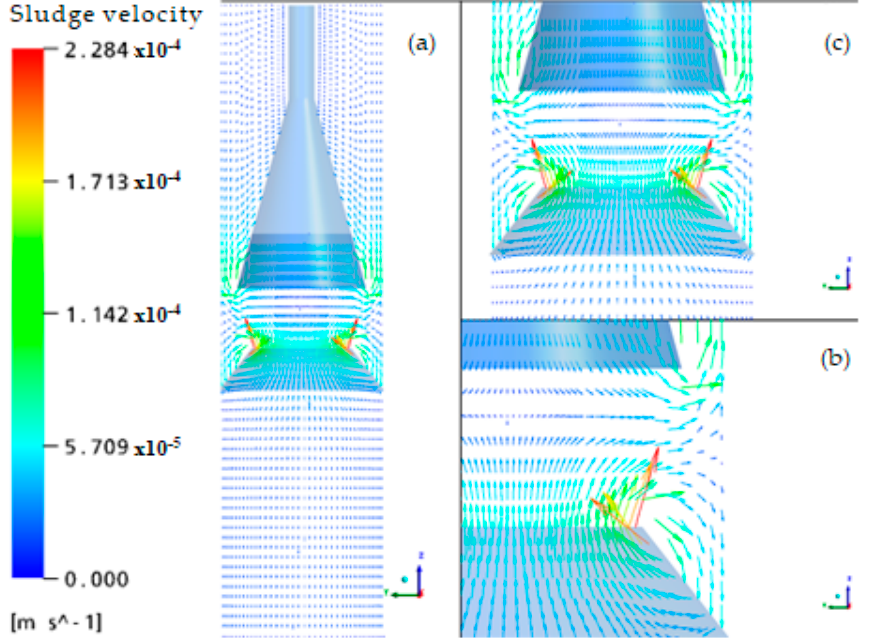
Figure 7. Biogas velocity vector in the reactor with deflector inclination upwards: ( a ) overview, ( b ) detail of the region between the gas deflector and the three-phase separating element, and ( c ) detail of the region corresponding to the settling zone. Water 2020 , 12 , 279